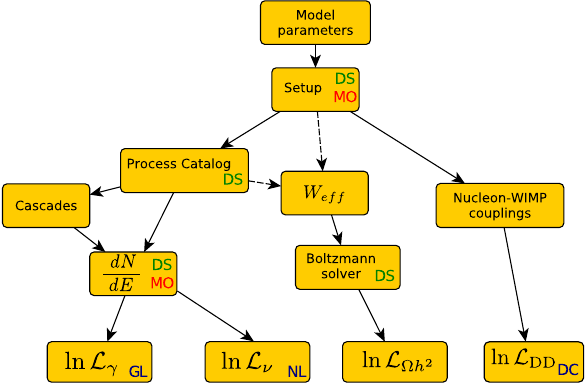
Fig. 1 Schematicoverview overdifferent DarkBit components. Based on the parameters of the scanned model(s), a Process Catalogue is ini- tialised. This contains the relevant particle physics processes to infer dark matter annihilation spectra. The effective annihilation rate rele- vant for relic density calculations can (in simple cases) be inferred from theprocesscatalogue,oritcanbesetdirectly.WIMP-nucleoncouplings are also set depending on the model. All information is channelled into various likelihood routines. The two-letter insets indicate what backend codes can be used: DarkSUSY (DS), micrOMEGAs (MO), gamLike (GL), nulike (NL) and DDCalc (DC). Currently the neutrino spectra cancalculatedin DarkBit usingonly DarkSUSY